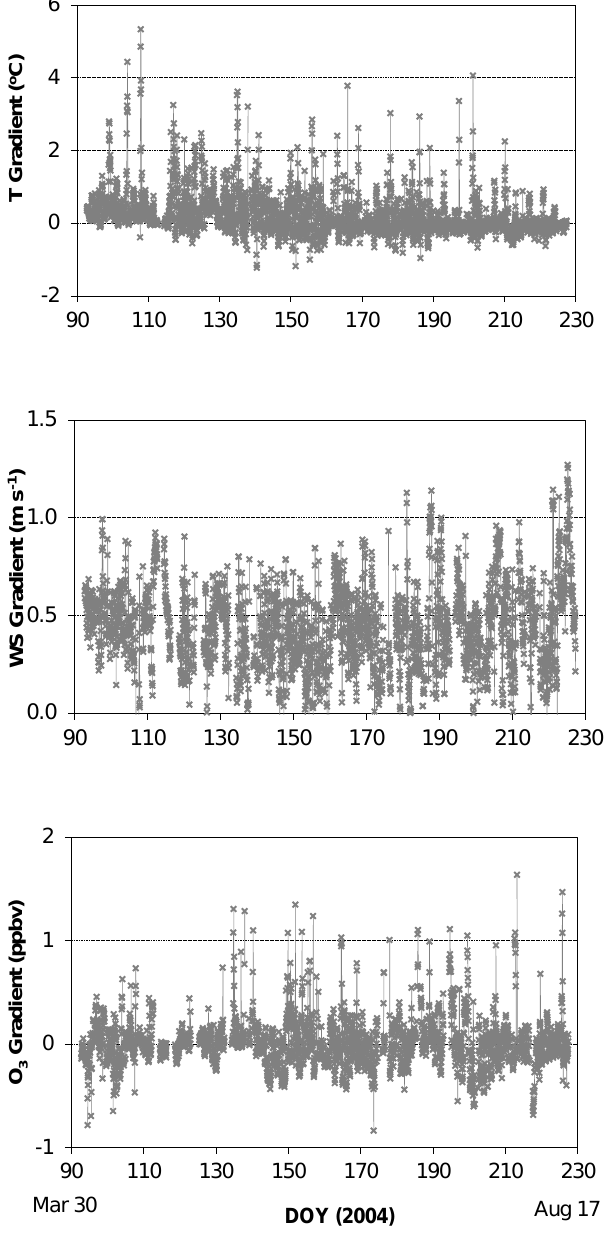
Fig. 6. The { 2–0.75m } gradients for temperature (T ) , wind speed (WS) and ozone (O 3 ) during the 2004